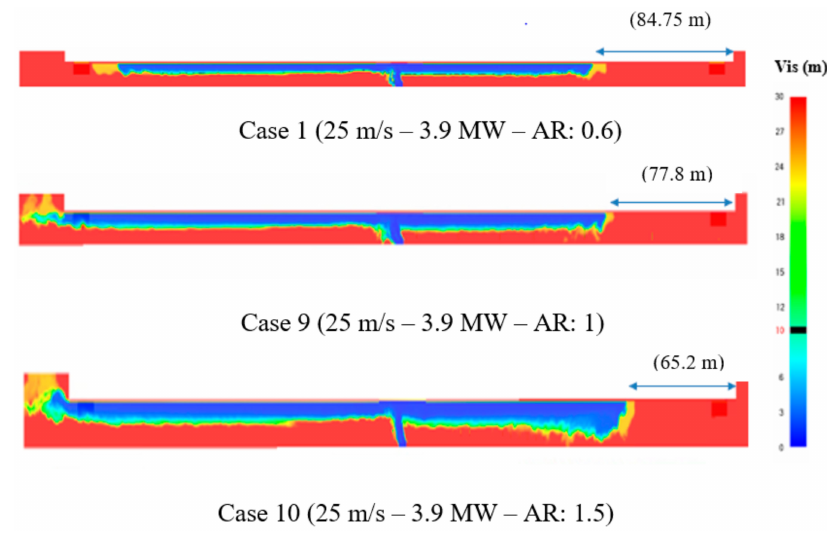
Figure 11. Visibility in the tunnel fire when changing the aspect